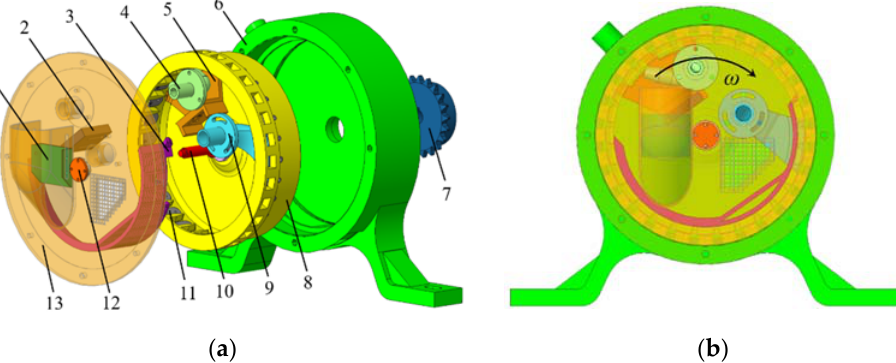
Figure 11. Structural schematic diagram of the inside ‐ filling pneumatic cotton precision seed ‐ me ‐ tering device. ( a ) Decomposition schematic diagram of seed ‐ metering device; ( b ) front view of the seed ‐ metering device. 1, Altitude adjusting plate for seed layer; 2, base; 3, seed protection board; 4, seed disturbing air nozzle; 5, eliminating finger; 6, back shell; 7, sprocket; 8, seeding plate; 9, seed throwing air nozzle; 10, seeding shaft; 11, suction hole replacement plate; 12, bearing end cover; 13, front shell.